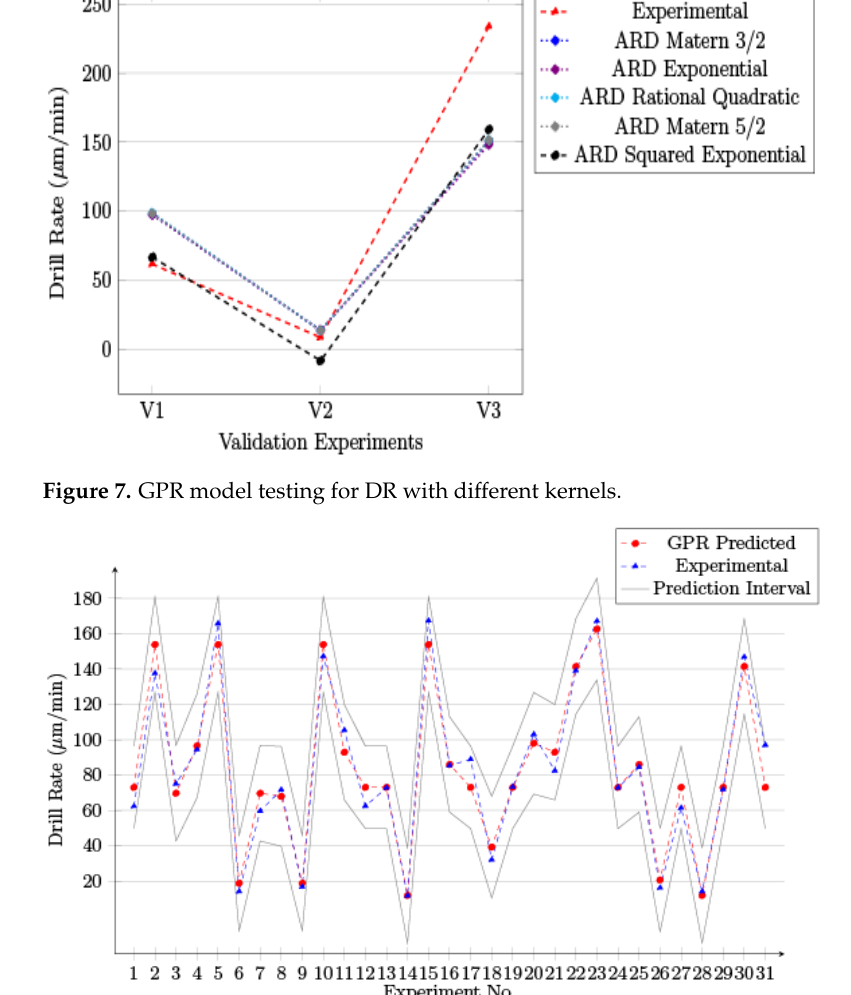
Figure 6. Experimental and GRNN predicted values for DR training data.